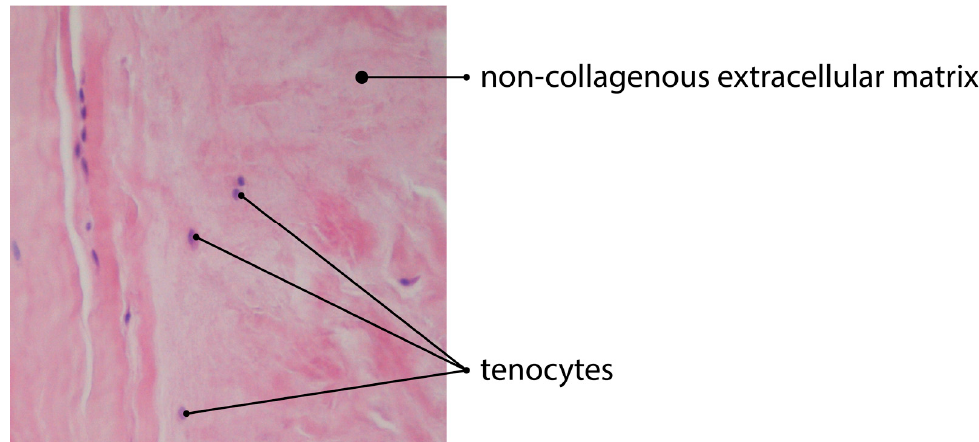
Figure 2. H&E staining of tendinous tissue showing impaired angiogenesis due to deposition of non-collagenous ECM (magnification of the objective: 20 × ). J. Clin. Med. 2022 , 11 , x FOR PEER REVIEW